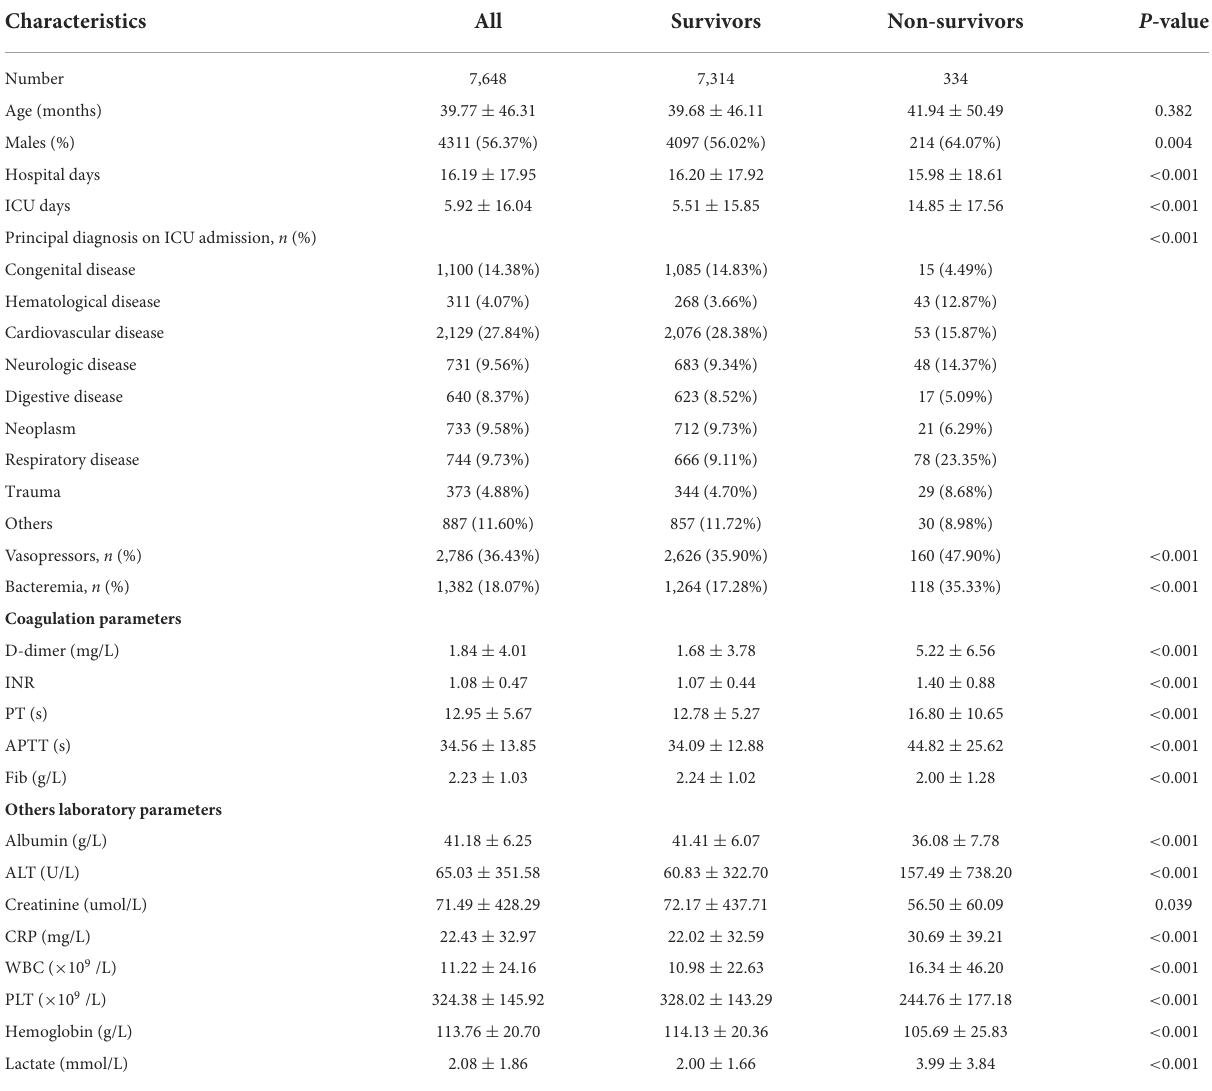
TABLE 1 Baseline clinical and laboratory characteristics of the study